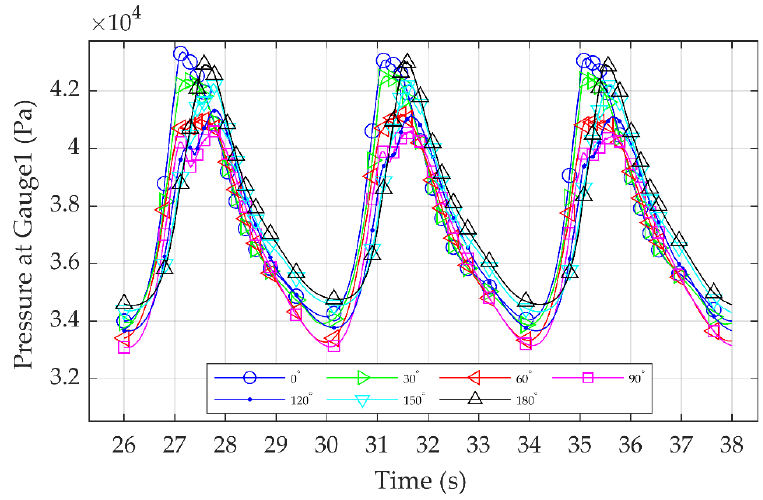
Figure 10. Dynamic pressure at Gauge 1 at different angles around the substructure.